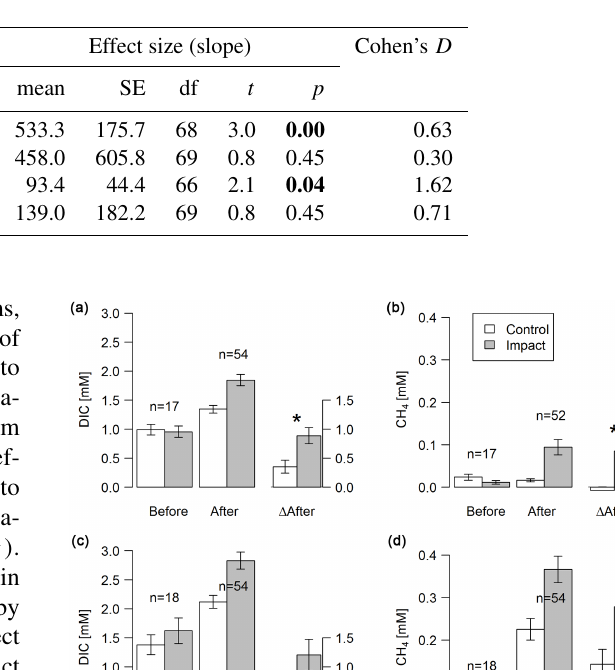
Table 3. Effect size of forest clear-cutting on DIC and CH 4 concentrations [µM] in groundwater in the impact catchments as shown in Fig. 3. Given are linear mixed-effects model slope estimates (mean), their standard errors (SEs), degrees of freedom (df), t and p values, and Cohen’ D . Statistically significant p values ( < 0 . 05) are highlighted bold.